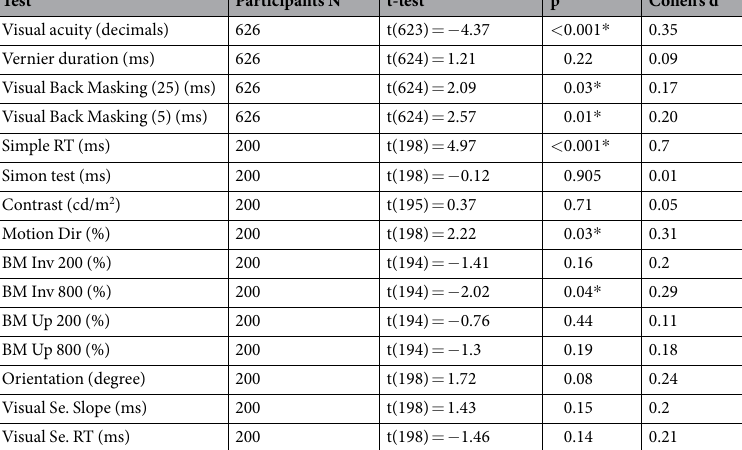
Table 2. Independent samples t-test for the three perceptual tests in Sample A and seven additional tests in Sample B (see also Table 1). Out of the three tests, two were significant and out of the additional seven tests, three were significant. Only the RT test showed a large effect size.